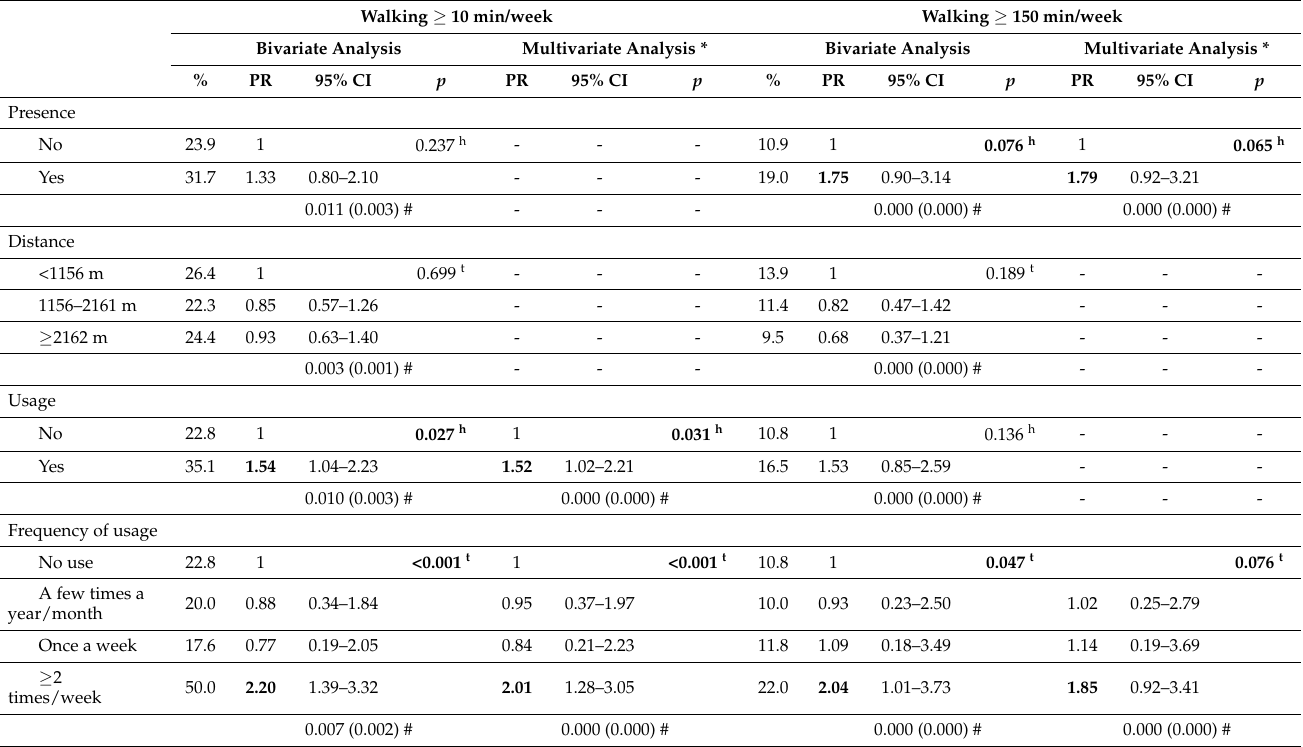
Table 3. The multilevel associations between exposure to public open space and walking in